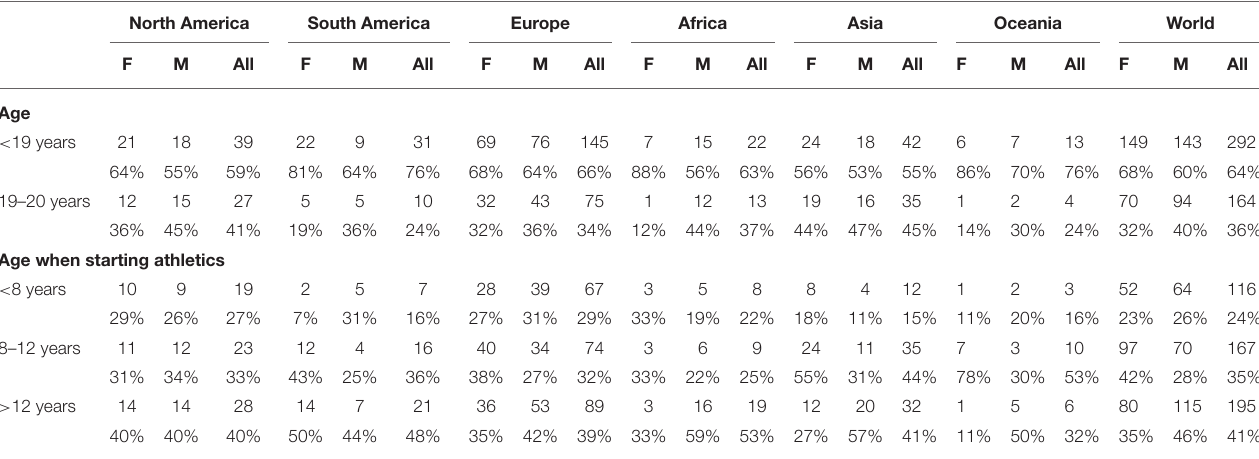
TABLE 2 | Participants’ age and athletics history by gender and geographical area. North